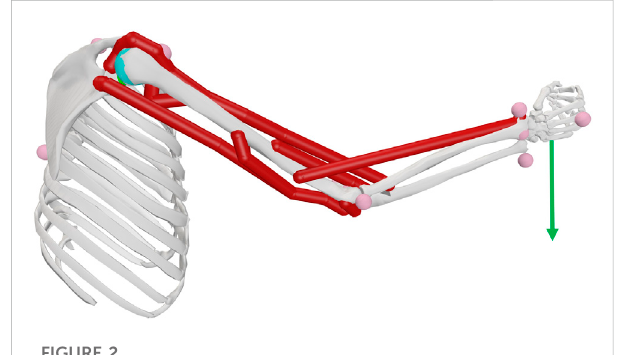
FIGURE 2 Upperrightextremity modelincludingtheelbowjointwithseven muscle actuators represented. Note the external force is represented by the green arrow applied at the hand center of mass (COM).